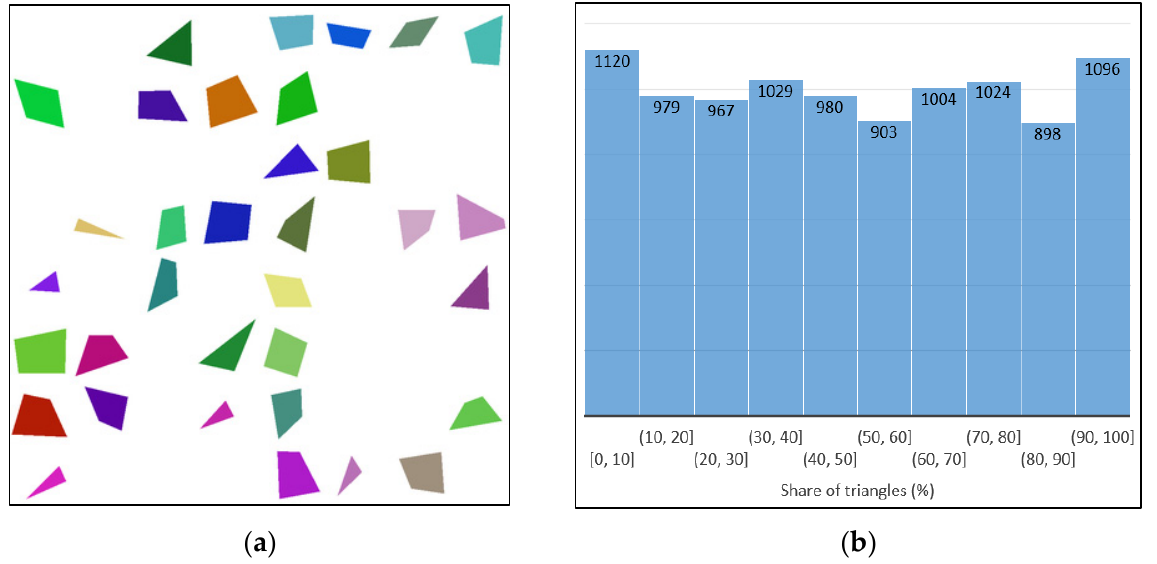
Figure 1. Toy dataset ( a ) Sample image; ( b ) Distribution of the share (percentage) of triangles for all images in the dataset.